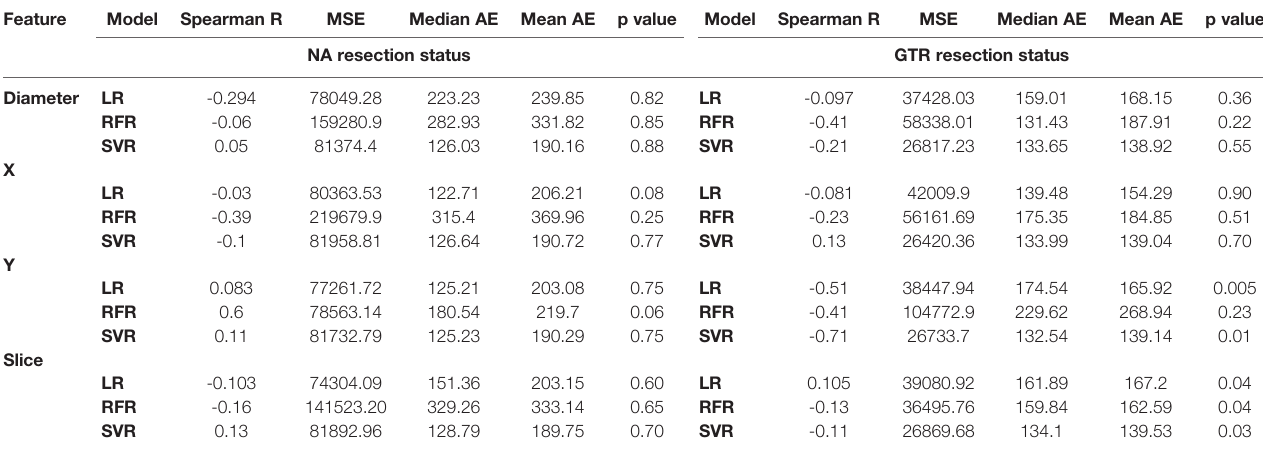
TABLE 1 | Performance comparison of regression models for the different types of resection status. Feature Model Spearman R